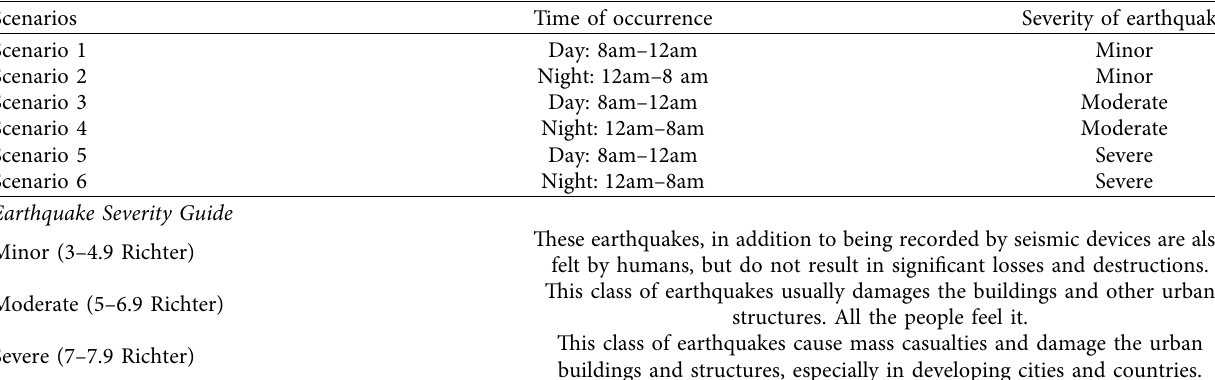
Table 2: Designated scenarios in the questionnaire.